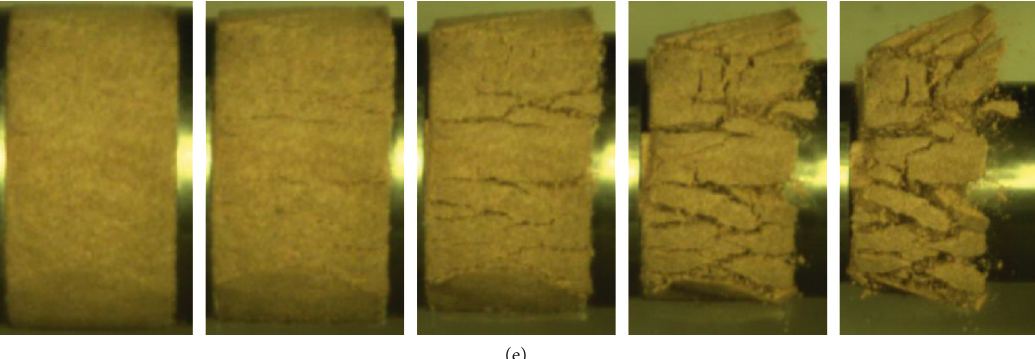
Figure 12: The macroscopic damage process of yellow sandstone under different freeze-thaw temperatures: (a) T �− 5 ° C, (b) T �− 10 ° C, (c) T �− 15 ° C, (d) T � − 20 ° C, and (e) T �− 30 °